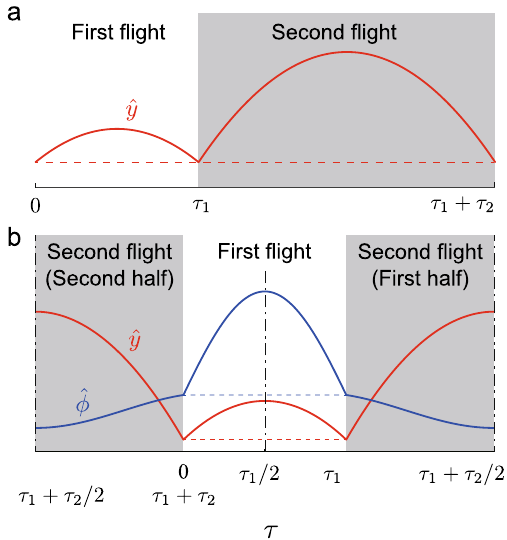
Figure 8. Symmetry condition for periodic solution. ( a ) solutions with respect to τ